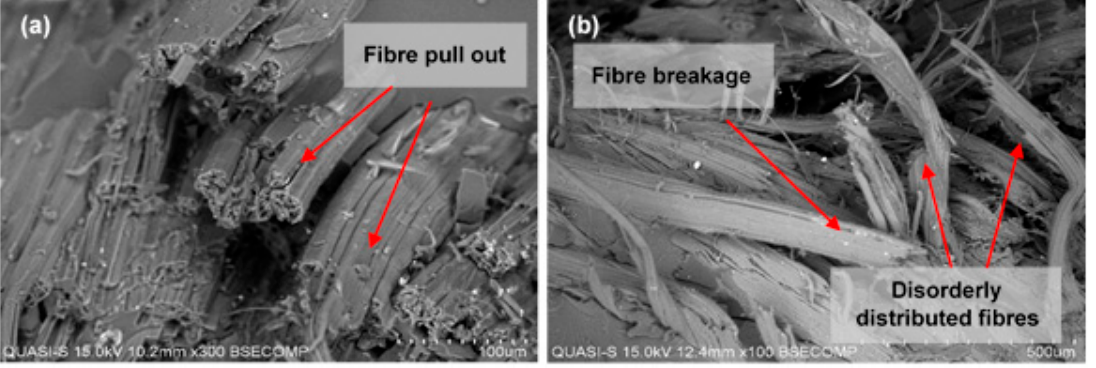
Figure 9. The SEM micrograph images of the flexural failure surfaces of woven kenaf/carbon fibre hybrid composite: (a ) fibre breakage and ( b ) fibre pull-outs and disorder arrangement of fiber on the tested specimens.